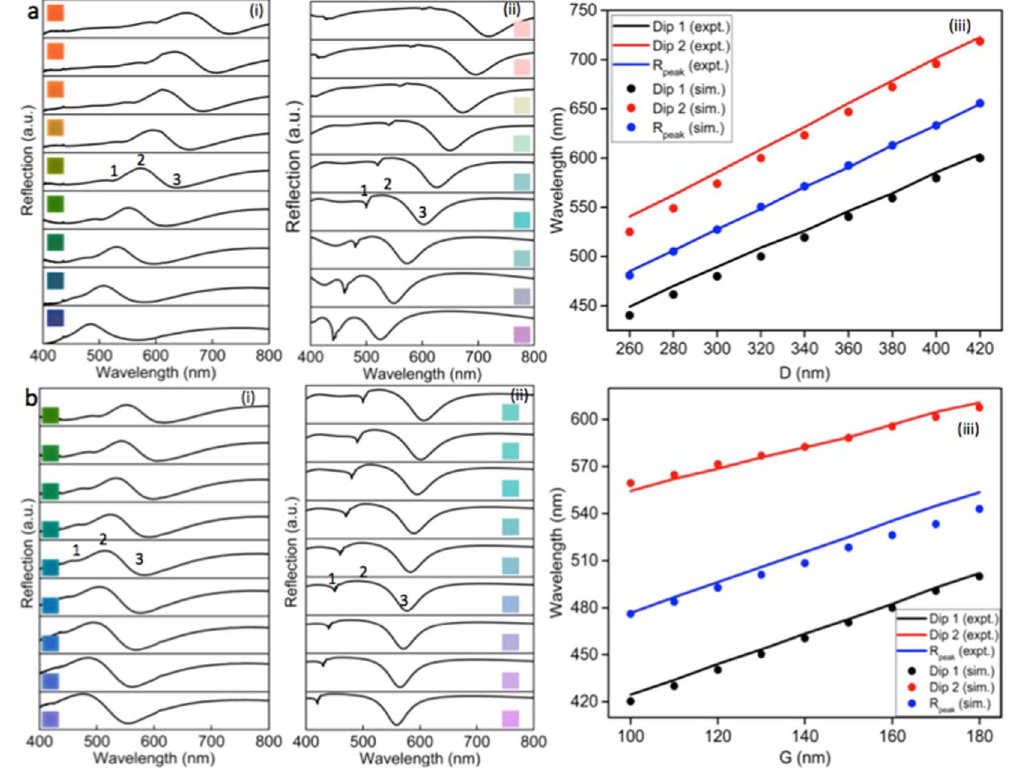
Figure 3. Spectral analyses of the colour pallets using micro-spectroscopic technique and a comparison between measured and simulated spectra. ( a ) Spectral analyses of selected colour pallets with varying D and fixed G, (i) experimental spectra of the colour pallets (inset shows the corresponding colours) with a fixed gap size G of 180 nm and a varying square size D from 260 nm to 420 nm, (ii) corresponding simulated spectra using FDTD algorithm with the inset shows predicted colours from the simulated spectra for each colour pallet and (iii) experimentally (lines) observed resonance dip and peak shifts as a function of D and its comparison with the simulated (dots) values. ( b ) Spectral analyses of selected colour pallets with varying G and fixed D, (i) experimental spectra of the colour pallets (inset shows the corresponding colours) with a fixed square size D of 320 nm and a varying gap size G from 100 nm to 180 nm, (ii) corresponding simulated spectra using FDTD algorithm with the inset shows predicted colours from the simulated spectra for each colour pallet and (iii) experimentally (lines) observed resonance dip and peak shifts as a function of G and its comparison with the simulated (dots) values. Positions marked as 1, 2 and 3 in all figures represent Dip1, R peak , and Dip2,